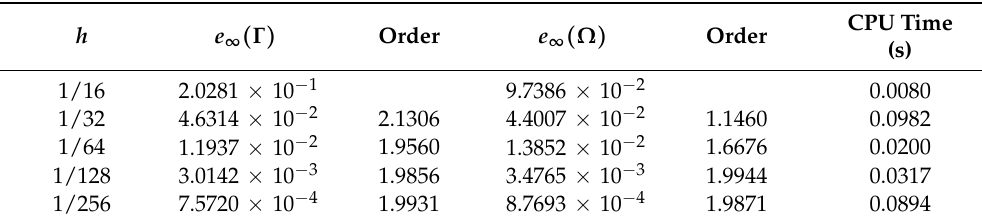
Table 1. Numerical convergence orders of the second-order fast algorithm with k 0 = 8 π m − 1 , ε r = 4 + i.